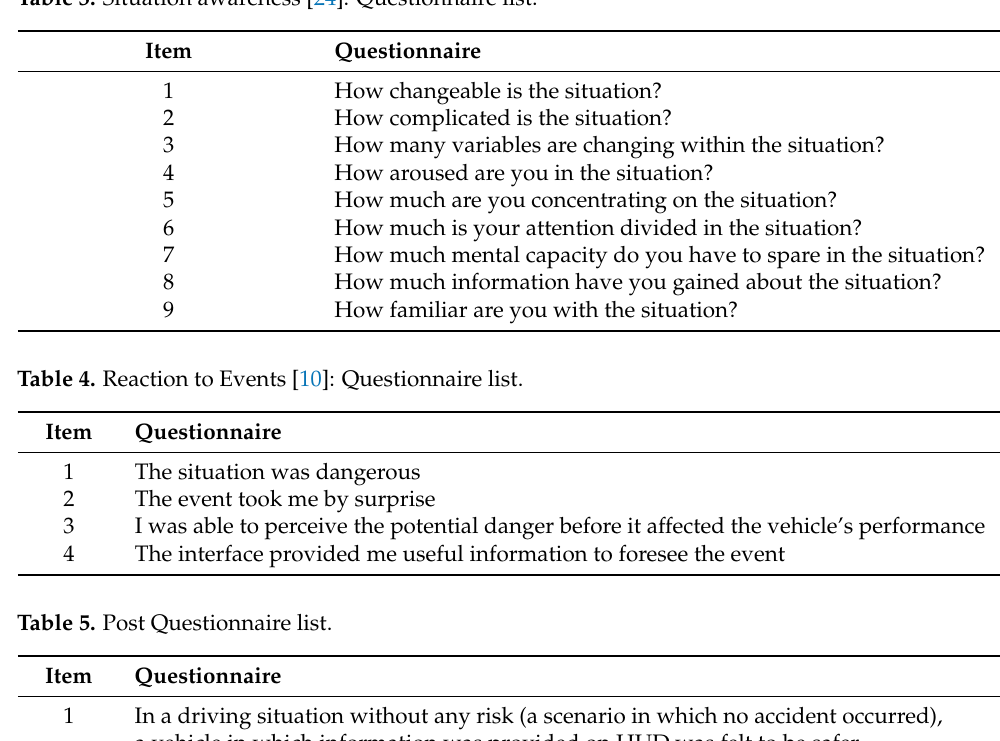
Table 3. Situation awareness [24]: Questionnaire list.